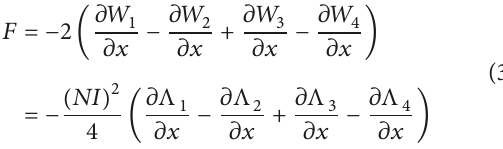
Figure 2: Equivalent magnetic circuit of